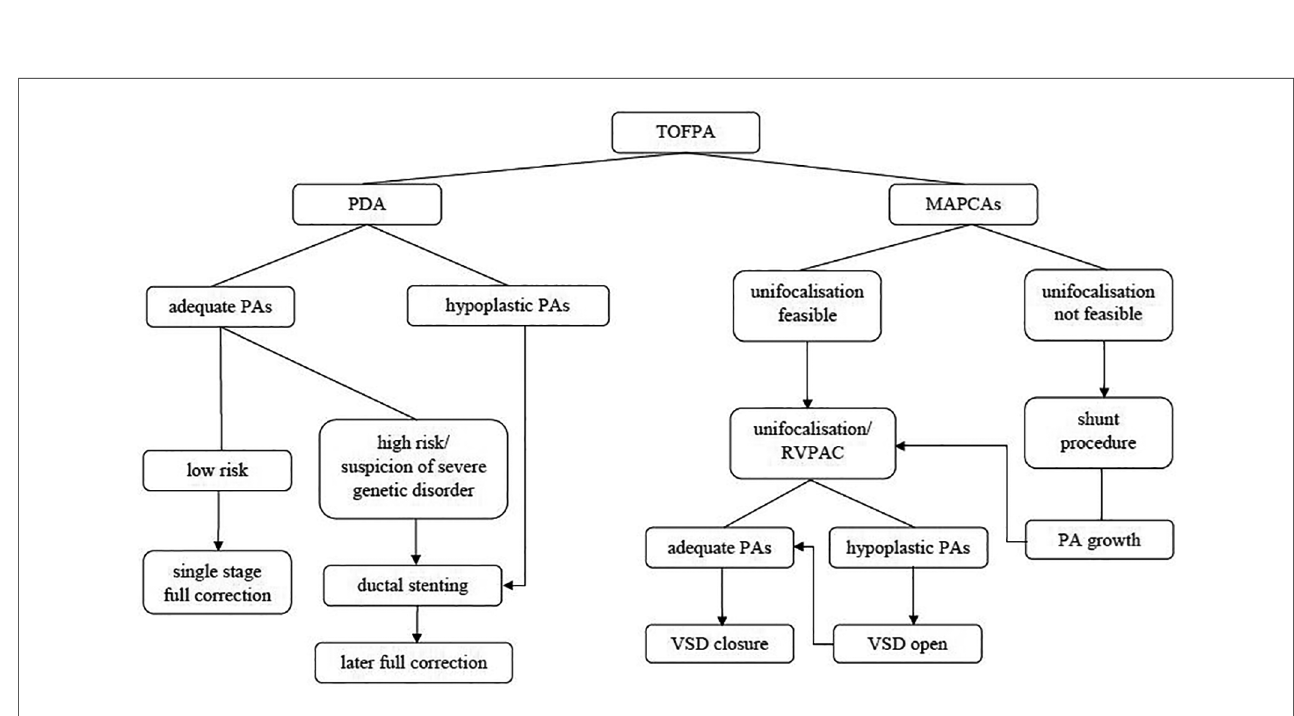
FIGURE 5 Decision